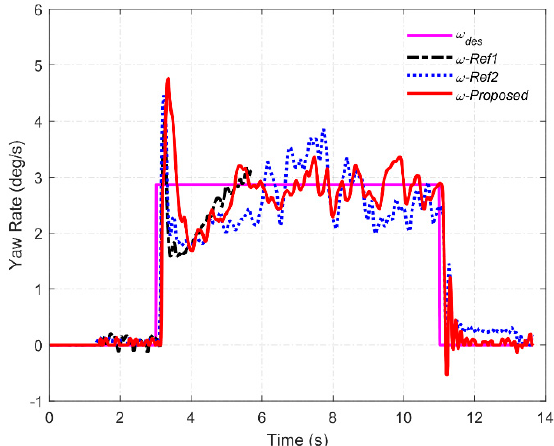
Figure 15. Yaw rate tracking.